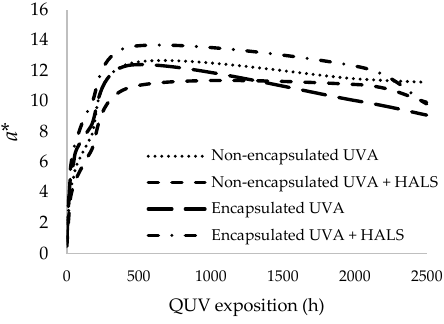
Figure 15. a * component evolution for the different formulations studied with QUV exposure.